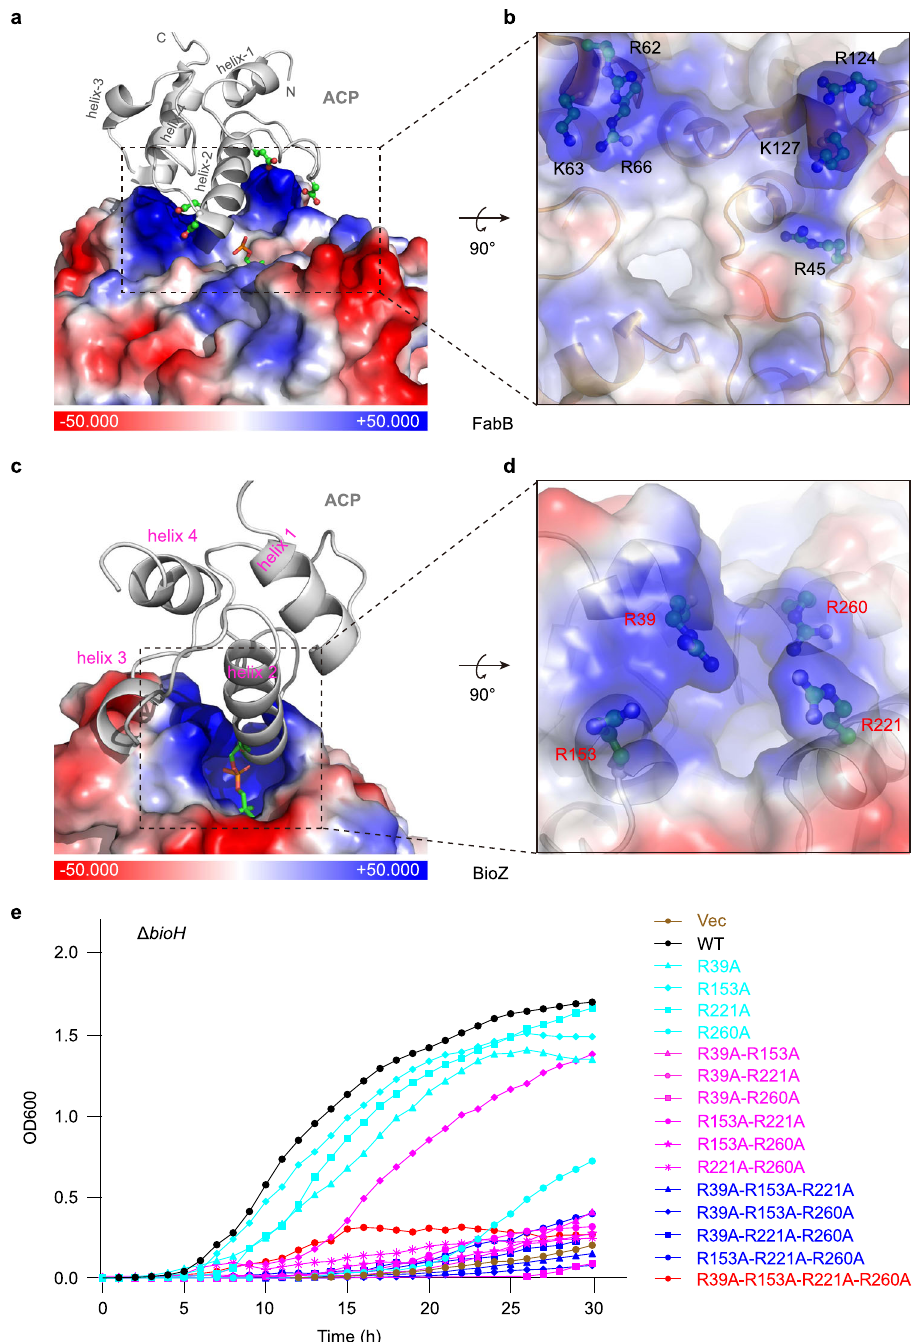
Fig. 7 Structural insights into the recognition of malonyl-ACP by the BioZ enzyme. a Structural display of the ACP moiety of acyl-ACP substrate bound to the paradigm enzyme of FAS I, the E. coli FabB. b An enlarged view of the ACP-interacting interface of FabB that is constituted by six positively-charged residues. The image is generated through a counter-clockwise 90° rotation of the rectangle-dashed lined region ( a ). c Binding model of glutaryl-ACP to the positively-charged surface of AtBioZ. ACP is given in ribbon structure colored gray, which comprises four α -helices (helix-1 to helix-4). The interface of FabB ( a ) [and/or BioZ ( c )] interacting with ACP group is illustrated in the surface electrostatic structure. The blue denotes positive charge, whereas the red refers to negative charge. d Visualization of the putative ACP-binding domain of BioZ. Presumably, it contains four basic residues, namely R39, R153, R221, and R260. This image is given through the counter-clockwise 90° rotation of the square-dashed lined region ( c ). e Growth curve-based assay to probe the role of the putative four basic residues-comprising, ACP-binding interface in the BioZ function. The strains used here were listed in Supplementary Table 1, and the growth curve was plotted as described in Fig. 5e. A representative result was given.